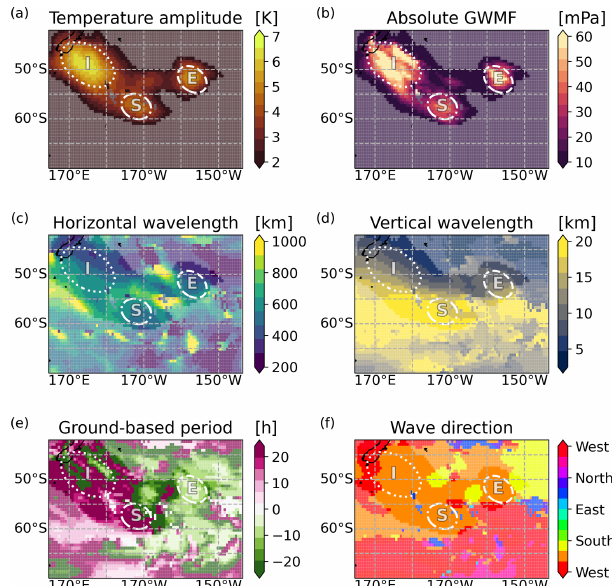
Figure 3. Horizontal maps of gravity wave parameters from sinu- soidal fits in 35 × 21 × 21 grid point cubes applied on ECMWF-IFS temperature perturbations of 1 August 2014 at 12:00UTC. Cubes are centred around 25km altitude. Hence, the panels show different gravity wave parameters for 25km altitude. (a) Temperature am- plitudes. (b) GWMF. (c) Horizontal and (d) vertical wavelengths. (e) Ground-based period. (f) Wave propagation direction. The let- ters in panel (a) refer to the locations of the different amplitude max- ima (I – island; S – south; E – east), as described in Sect. 3.1. For amplitudes larger than 2K, the colours are as given by the respec- tive colour bars (bright colours). For smaller amplitudes, colours are weakened by a milky shading to indicate less significant wave